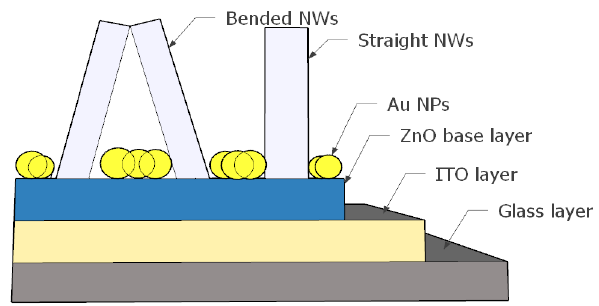
Figure 9. Proposed structure with Au NPs distributed on the top of the ZnO layer. The absorption for bent (ZnO NWs) without (NPs) and with (Au NPs) having a ra- dius (R) of 10 nm, 20 nm and 30 nm, respectively, is shown in Figure 10. The absorption for R = 10 nm is enhanced in the visible region and in the (NIR) region, from 2.2 µm to 2.6 1570 nm for the 10 nm (Au NPs), while the intensity decreases from 78% (no NPs) to 61% (with NPs). On the other hand, the maximum absorption is 1650 nm for 20 nm (Au NPs) and shifted to 1580 nm for the 30 nm (Au NPs), while the intensity decreases from 88% (20 nm NPs) to 67% (30 nm NPs). (Au NPs) behave like a nanoantenna, which absorb the light is depending on the (Au NPs) size and periodicity as given in Equation (7). Changing